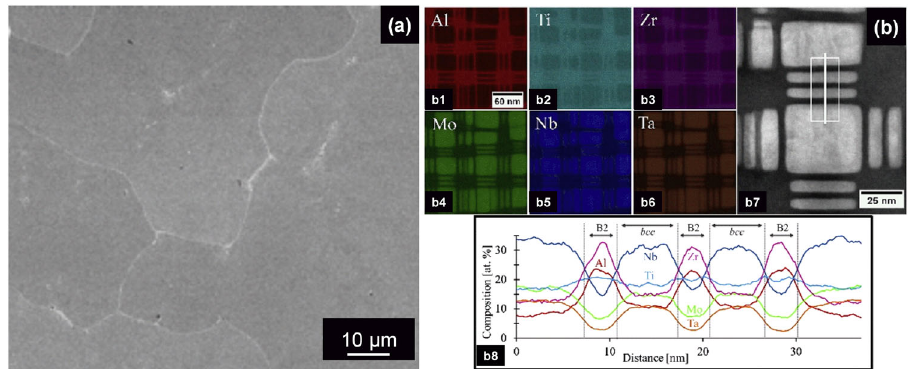
Fig. 1 a SEM micrograph of an as-cast Al 0.3 CoCrFeNi showing a single phase microstructure, 14 b (b1 – b6) XEDS elemental maps of Al, Ti, Zr, Mo, Nb and Ta, respectively, recorded in STEM using the Super-X ™ detector, (b7) A STEM-HAADF image with a white line identifying the location of the EDXS linescan shown in (b8). 5 ( a reprinted with permission from ref. 14 with permission from Elsevier; b reprinted from ref. 5 with permission from Elsevier)